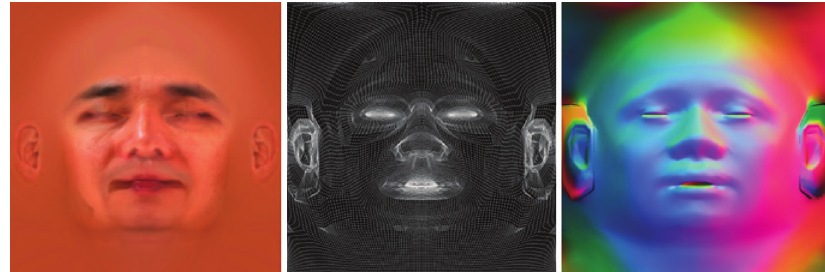
Figure 16. Predefined Map Source for SSS Rendering: Color Texture Map (Left), UV Coordinate Snapshot (Center), and Object Space Normal Map